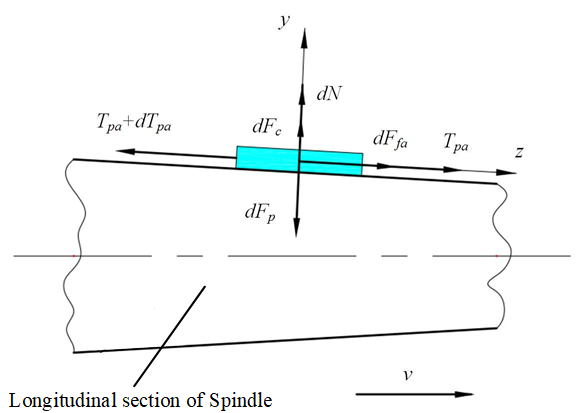
Figure 4. Free body diagram of the cotton sliver in the longitudinal section of the spindle.